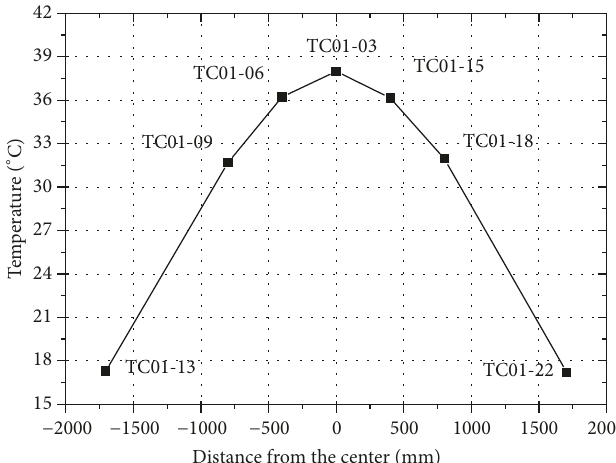
Figure 11: The experimental temperature distribution of support bottom in Test B1.